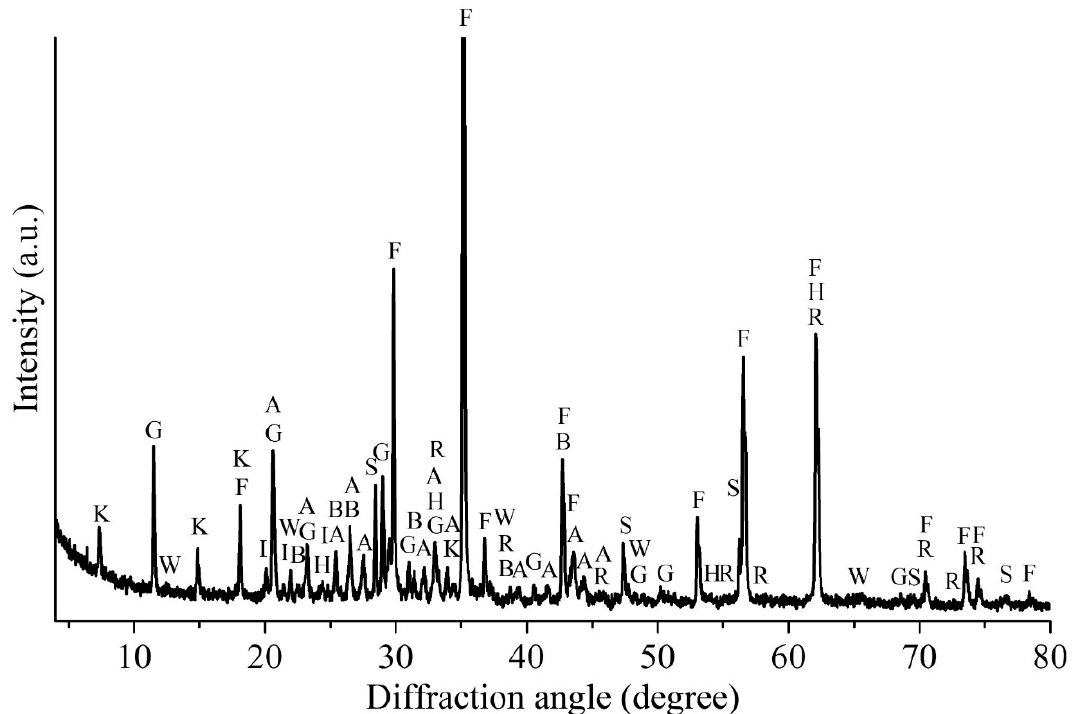
Figure 1. The XRD pattern of the ZPR sample, where F—ZnFe 2 O 4 (96–151–3088); K—Zn 2 (Cu 4.8 Zn 3.2 )(SO 4 ) 4 (OH) 12 · 12H 2 O